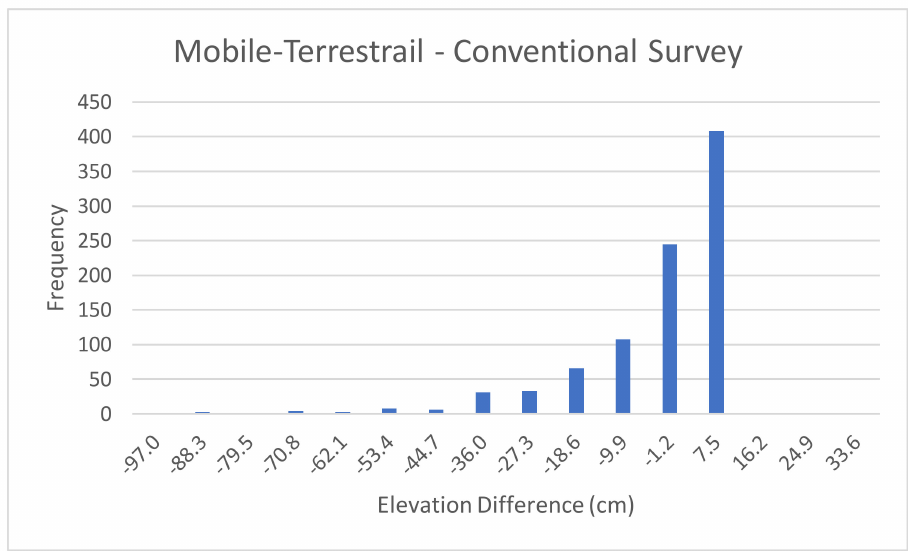
Figure 6. Elevation Di ff erence Between Mobile-Terrestrial Lidar and Conventional